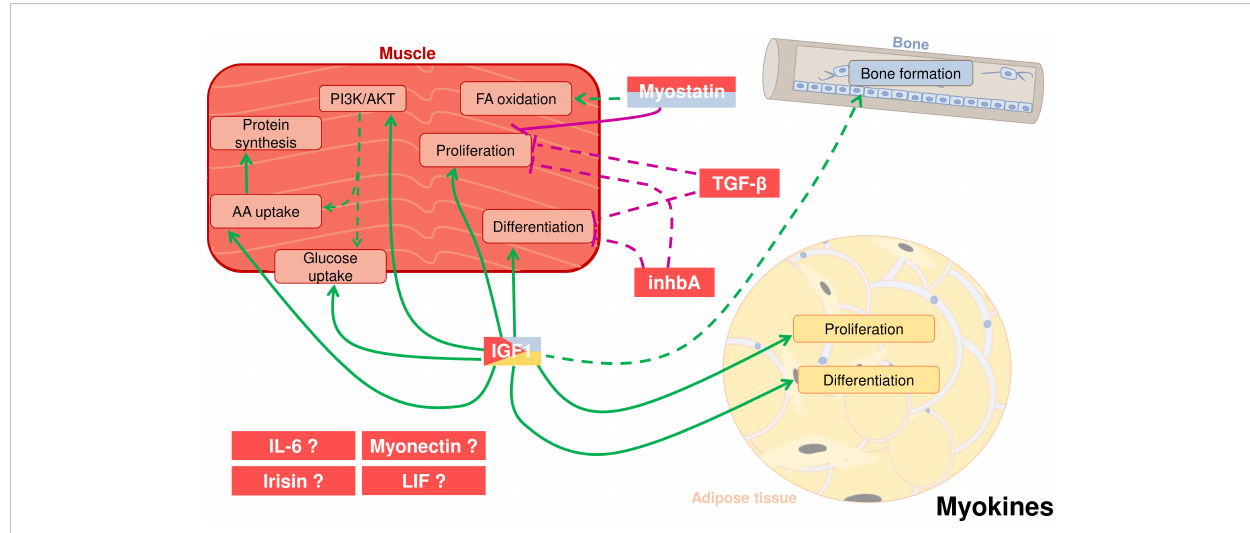
FIGURE 2 Crosstalk between adipose tissue, muscle, and bone in fi sh through cytokines secreted by the skeletal muscle, also known as myokines. Myostatin (MSTN) can be secreted by muscle but also from the bone. It has a potential positive effect on fatty acid (FA) oxidation and a proved negative effect on myocyte proliferation. Other two myokines most likely have autocrine roles: Transforming growth factor- b (TGF- b ) and inhibin A (inhbA) inhibit cell proliferation and differentiation in muscle. Insulin-like growth factor 1 (IGF-1), produced mostly by muscle but also by other tissues like adipose and bone, enhances in muscle cell proliferation and differentiation, activation of the PI3K/AKT pathway, glucose and amino acid (AA) uptake and protein synthesis. IGF-1 also induces proliferation and differentiation of adipose cells. Moreover, it is also hypothesized that IGF-1 has an in fl uence on bone formation. Other potential myokines are interleukin 6 (IL-6), irisin, myonectin, and leukemia inhibitory factor (LIF). Positive proved effects: green solid line; Positive suggested effects; green dotted line; Negative proved effects: purple solid line; Negative suggested effects: purple dotted